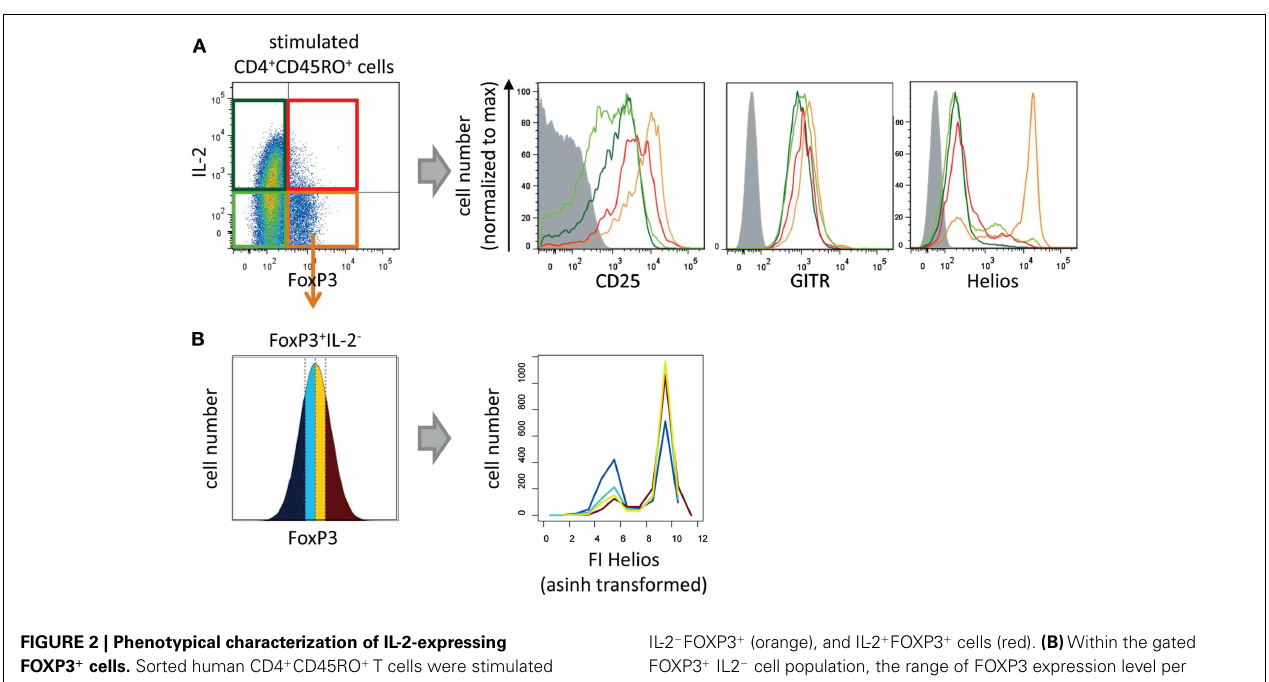
FIGURE 2 | Phenotypical characterization of IL-2-expressing FOXP3 + cells. Sorted human CD4 + CD45RO + T cells were stimulated with PMA/ionomycin for 5h and subsequently fixed, stained with fluorophore-coupled antibodies, and analyzed by flow cytometry. (A) Histograms show overlays of CD25, GITR, or Helios expression of gated IL-2 − FOXP3 − (light green), IL-2 + FOXP3 − (dark green),